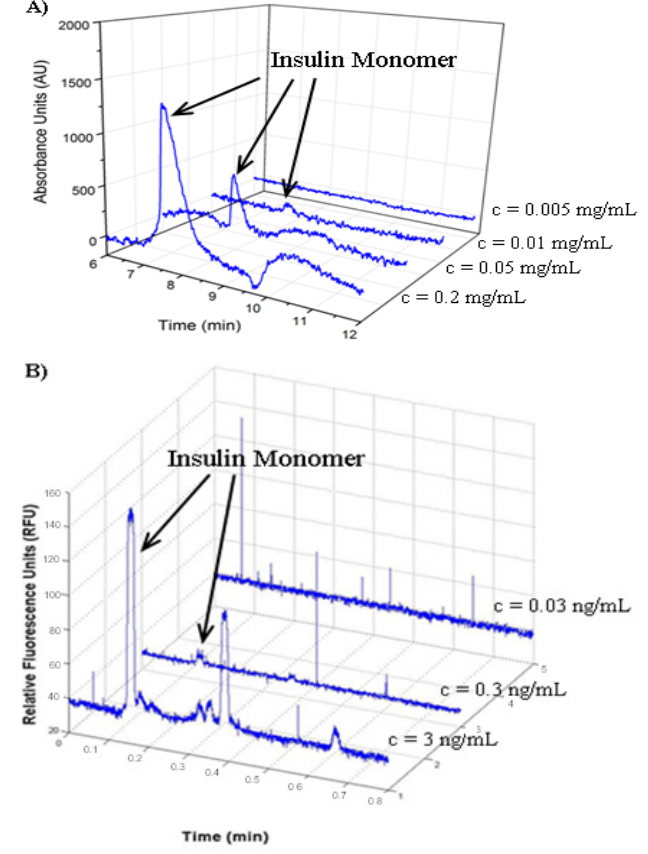
Figure 5. Limit of detection for monomeric insulin. ( A ) UV-CE detection of insulin with a 0.5 psi pressure injection for 8 s at 15 kV separation voltage using 0.1% PHEA separation matrix in a PHEA coated capillary; ( B ) LIF-CE detection of insulin with a 12 kV electrokinetic injection for 12 s at 15 kV separation voltage using 0.1% PHEA separation matrix in a PHEA coated